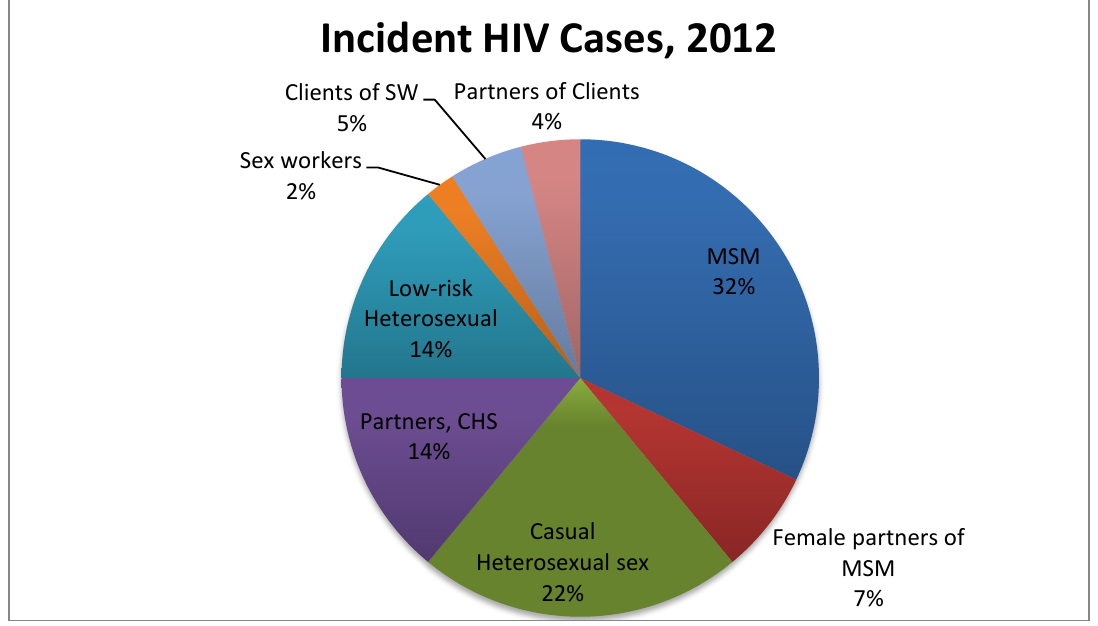
Figure 3: Estimated distribution of incident HIV cases in 2012